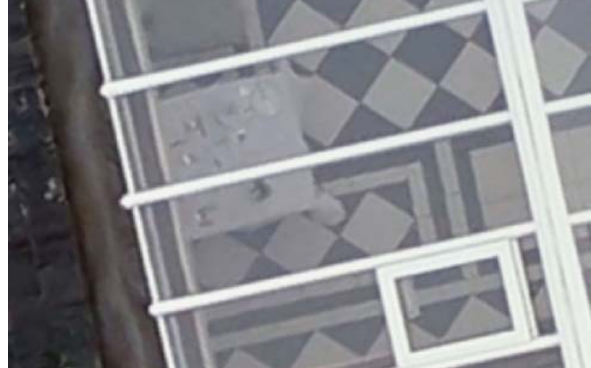
Figure 6: The detail of 1cm ortophotography can be seen here. This is a view looking down through the atrium over the dinning area of the surveyed hotel. Note the cutlery on the